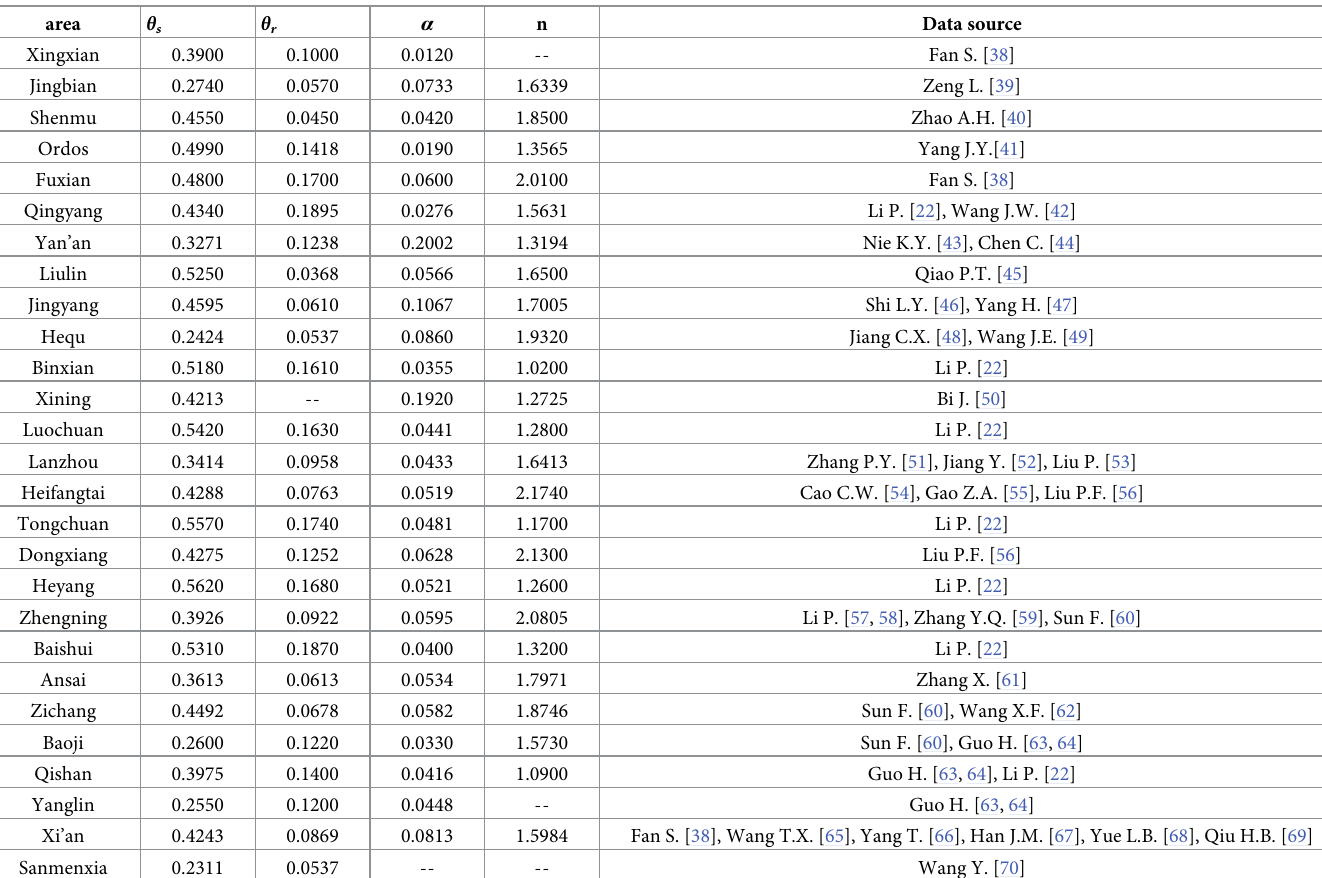
Table 1. VG model parameter